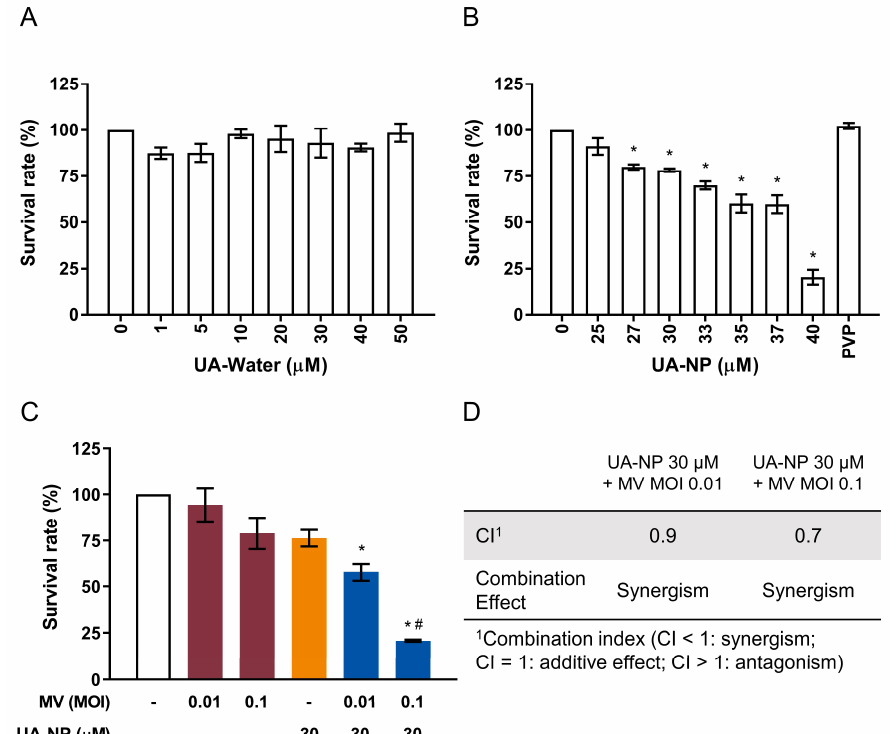
Figure 5 Figure 5. UA-NP retain cytotoxic activity against human breast cancer MCF-7 cells and exert synergistic anticancer activity in combination with oncolytic MV. MCF-7 cells were treated with ( A ) non-formulated UA mixed in water (UA-Water; 1–50 µ M) or ( B ) UA-NP solubilized in water (25–40 µ M) for 5 days, and cell viability was analyzed by MTT assay; PVP = 50 µ g/mL. ( C ) MCF-7 cells were concurrently treated with UA-NP (30 µ M) and MV (MOI 0.01 or 0.1) for 5 days, following which cell viability was determined by MTT assay. ( D ) Analysis of treatment synergism using the Chou-Talalay method as in Figure 1. All data shown are means ± SEM from three independent experiments; * p < 0.05 in ( A , B ); * p < 0.05 compared with MV MOI 0.01 or 0.1, # p < 0.05 compared with UA treatment only in ( C